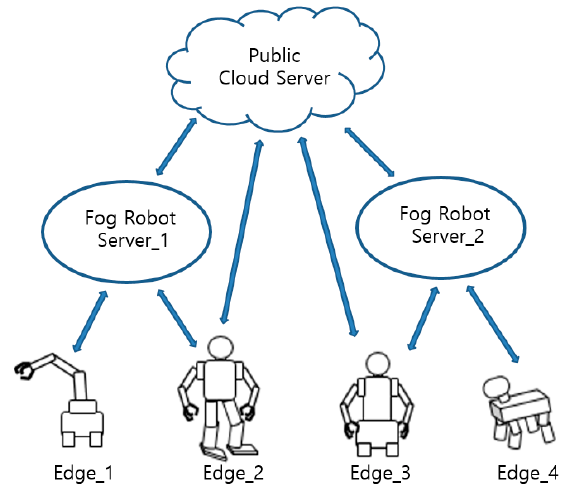
Figure 2. The schematic of function as a service based fog robotic (FaaS-FR) model.